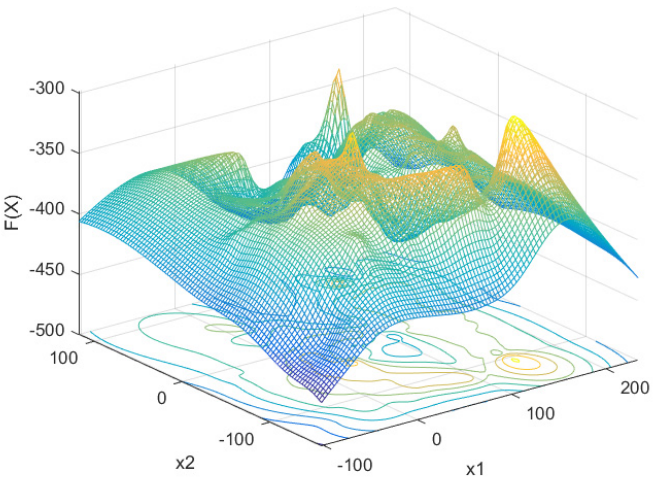
Figure 5. Landscape of a two-dimensional optimization problem. gbest is updated as follows.